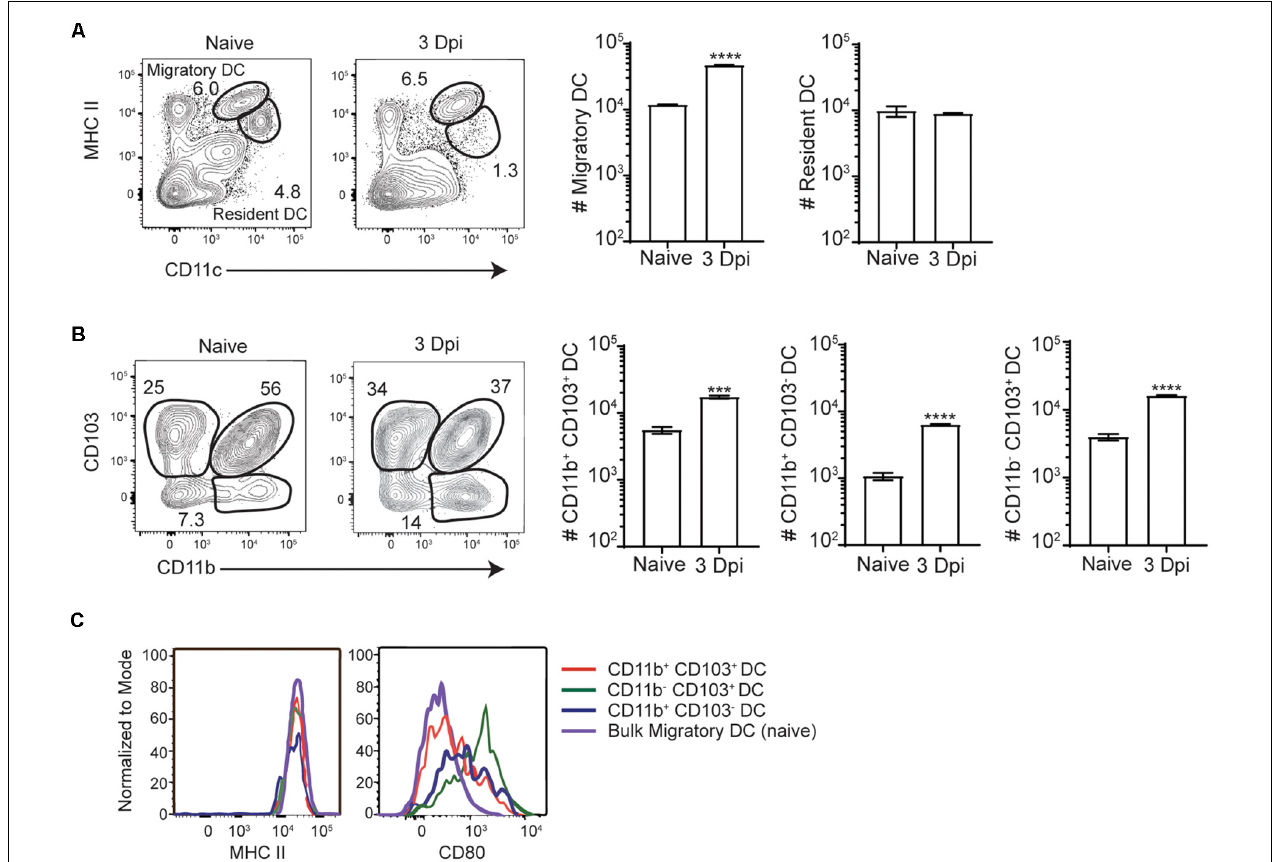
FIGURE 2 | Migratory DC are activated and accumulate in the MLN after foodborne InlA M Lm infection. MLN were harvested from Balb/c mice after foodborne infection with 2 × 10 9 CFU InlA M Lm 10403s and dendritic cells subsets were analyzed via flow cytometry. (A) Representative flow plots from the MLN of naïve and 3 dpi mice depicting the gating scheme used to identify migratory and resident DC subsets. The populations represented are gated on B220 − TCR β − single, live leukocytes. (B) Cell counts were calculated for migratory dendritic cell subsets at naïve and 3 dpi time points after infection. DC subsets were identified as noted previously, and cell numbers were calculated using cell frequencies and ViCell counts of total viable cells. (C) Representative histograms depicting CD80 and MHCII expression levels on migratory DC subsets. Cell subsets were gated as demonstrated in panels (A,B) . Data are representative of two independent experiments with 3–4 mice per group. Unpaired T -tests are reported: *** p < 0.001; **** p <